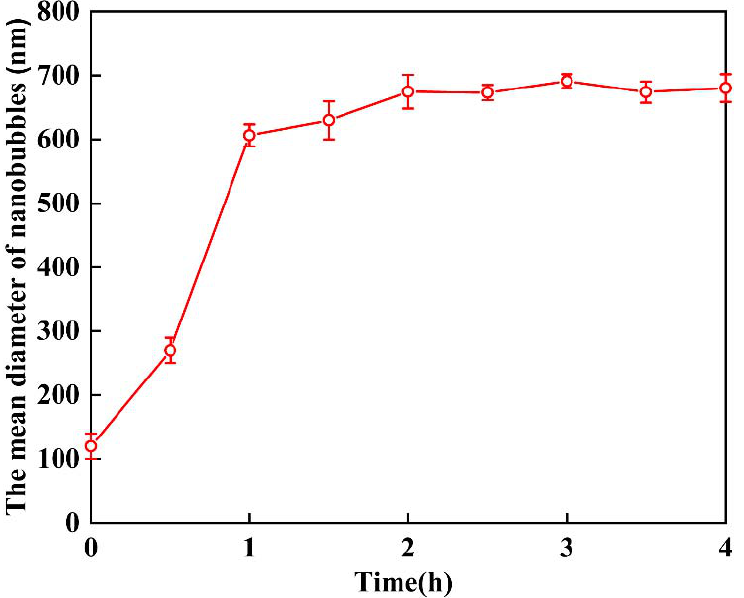
Figure 11. The mean diameter of nanobubbles in mixed vaterite and calcite suspension after reaction depending on the time measured by DLS after filtration with 10–15 μ m filter paper.